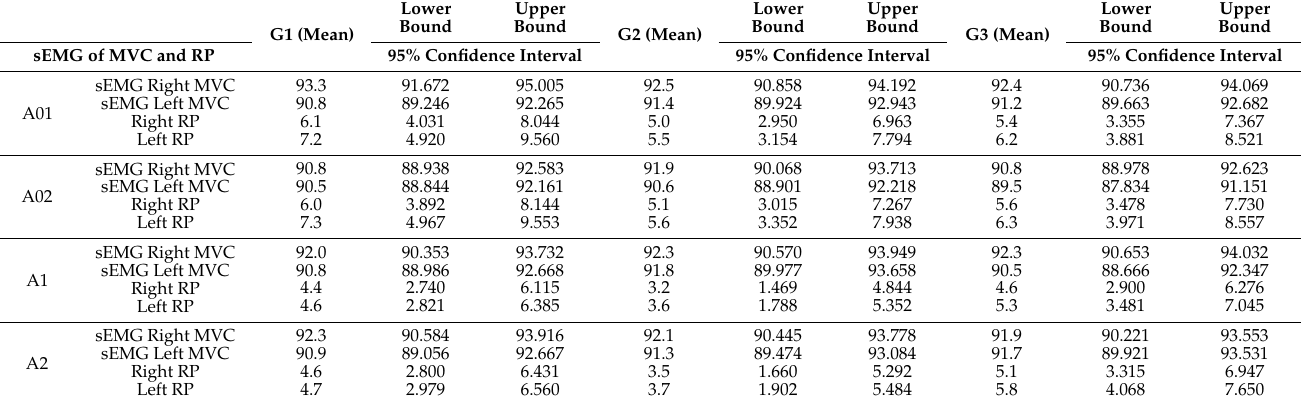
Table 1. Changes in sEMG during MVC and RP in each group at the different time